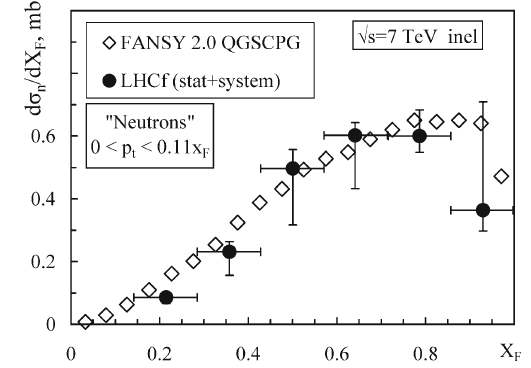
Fig. 6 LHCf[40]andFANSY2.0QGSCPG’s d σ/ dx F “neutron”cross sections at p t < 0 . 11 x F (GeV/c), Δφ = 360 ◦ ,